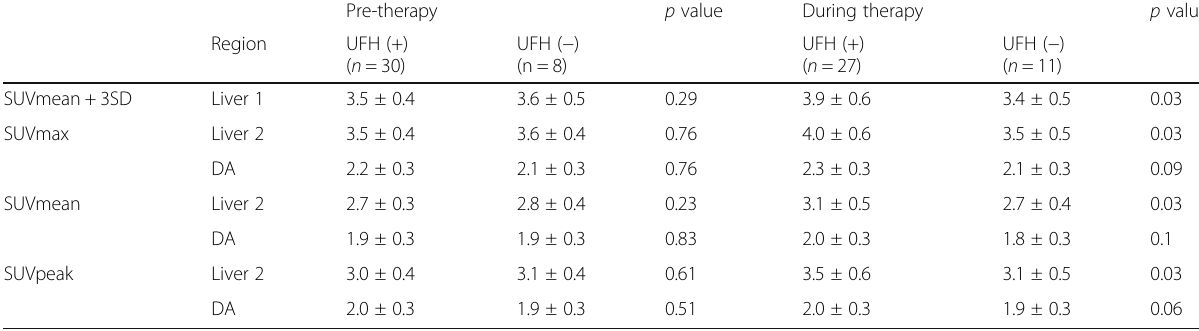
Table 4 The effect of UFH for the thresholds: a paired t test Pre-therapy p value During therapy